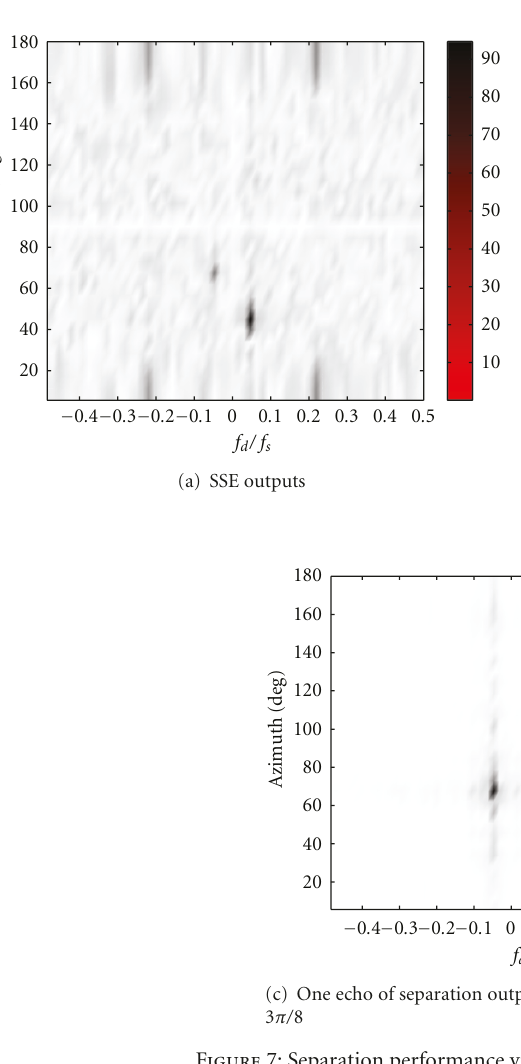
Figure 7: Separation performance via SSE with signal power ratio